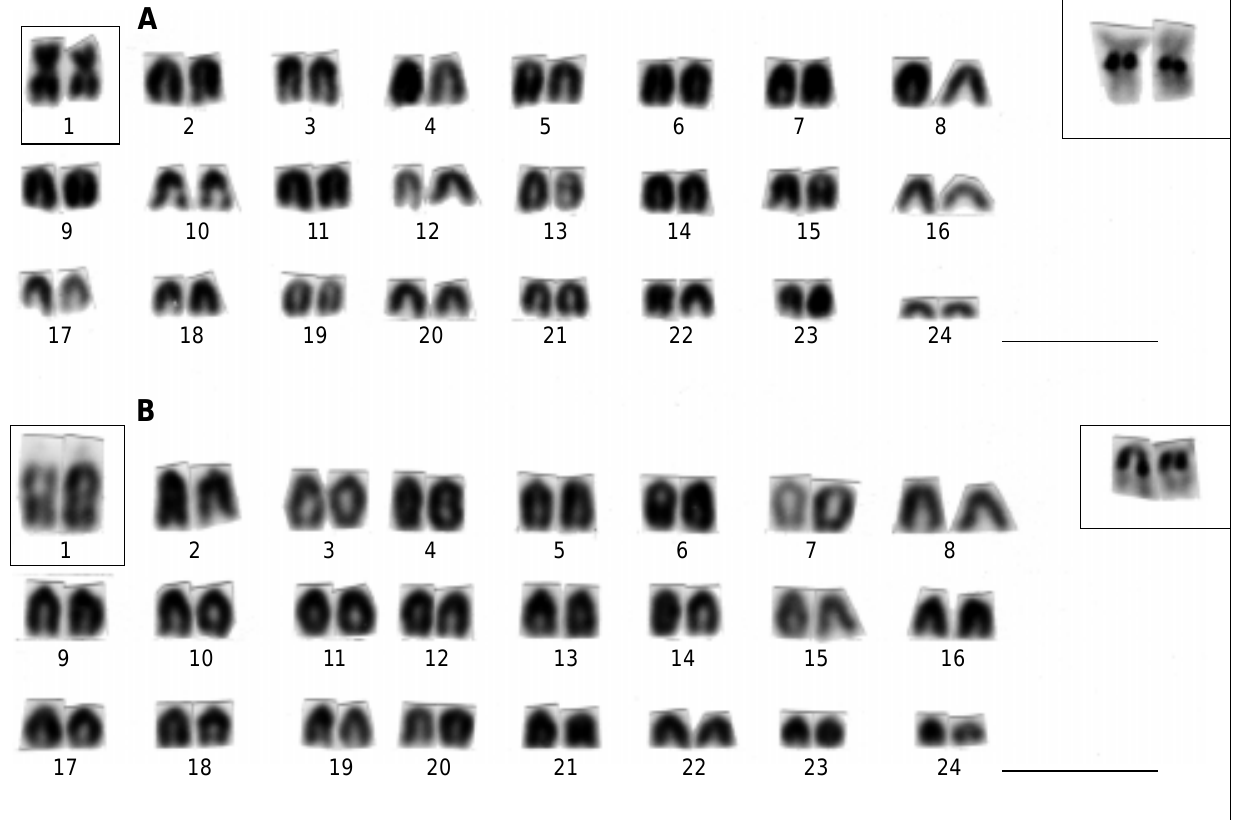
Figure 3 - Karyotype of Plagioscion sp. A) Cytotype a and B) cytotype b . NOR-bearing chromosomes appear in the square inset. Scale bar corresponds to 5 m